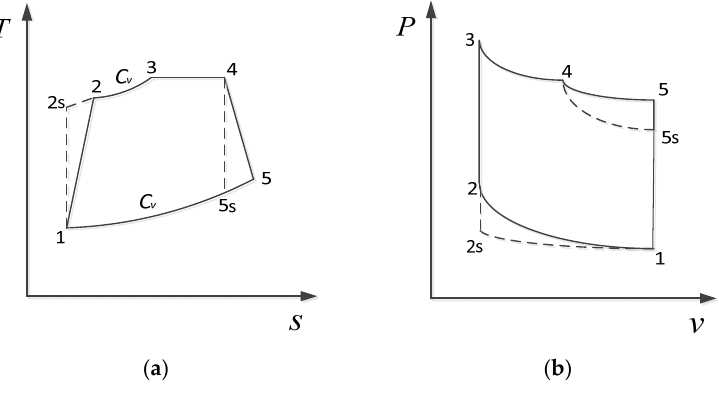
Figure 1. p − v and T − s diagrams. ( a ) T − s diagram. ( b ) P − v Figure 1. p v − and T s − diagrams. ( a ) T s − diagram. ( b ) P v − diagram.